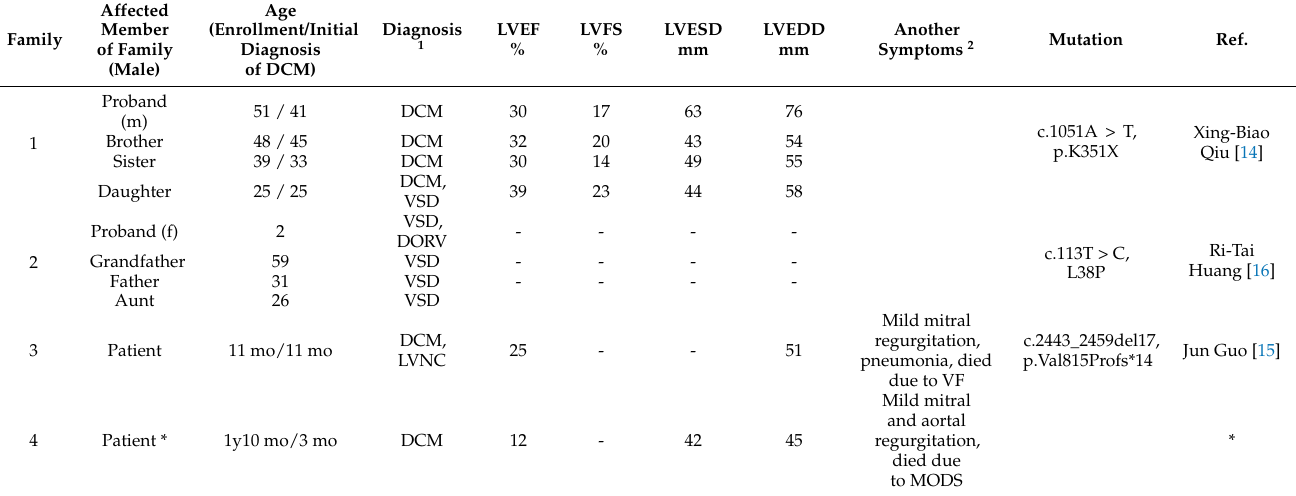
Table 1. Summary table with parameters of patients and their affected